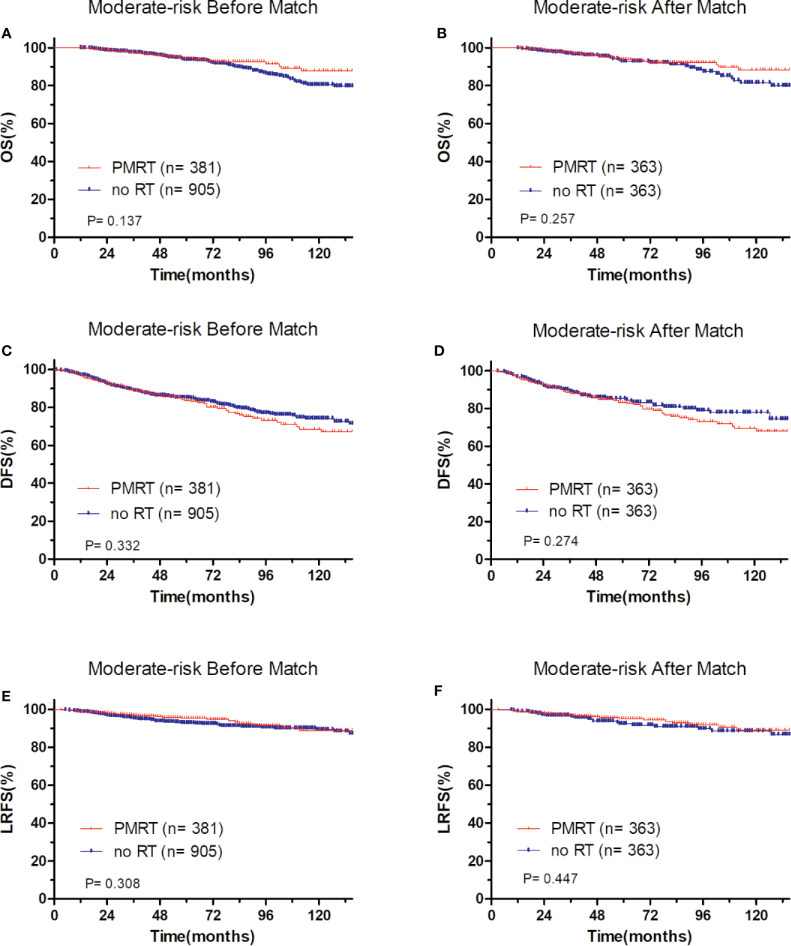
Comparison of OS and DFS and LRFS between with PMRT and without PMRT for moderate-risk pT1-2N1M0 patients. For patients with PMRT or without PMRT, OS before (A) and after (B) match stratification; DFS before (C) and after (D) match stratification; LRFS before (E) and after (F) match stratification.